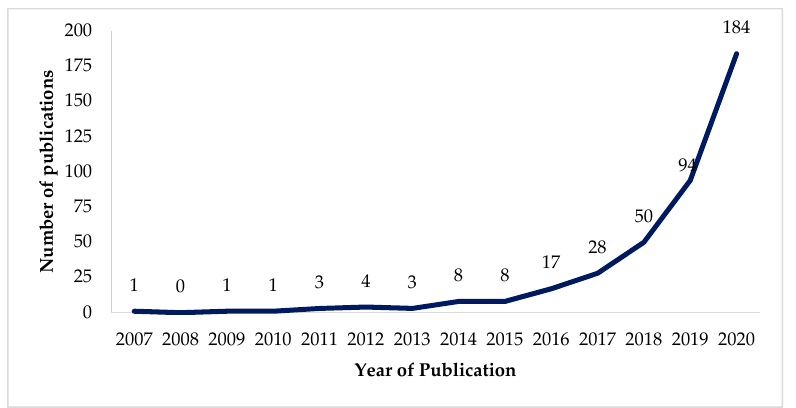
Figure 4. Trend in publication of papers related to logistics technologies in recent decades.